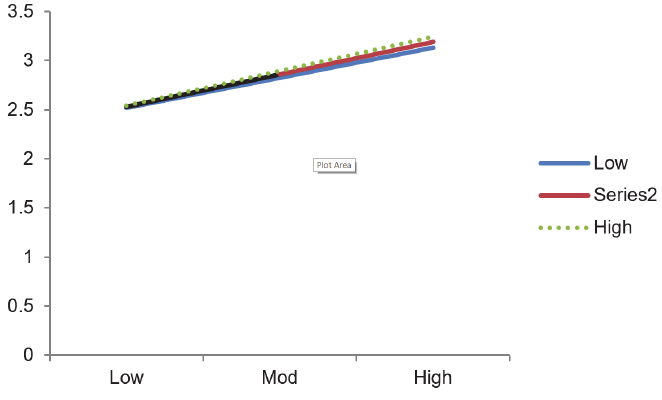
Fig. 2. Moderation